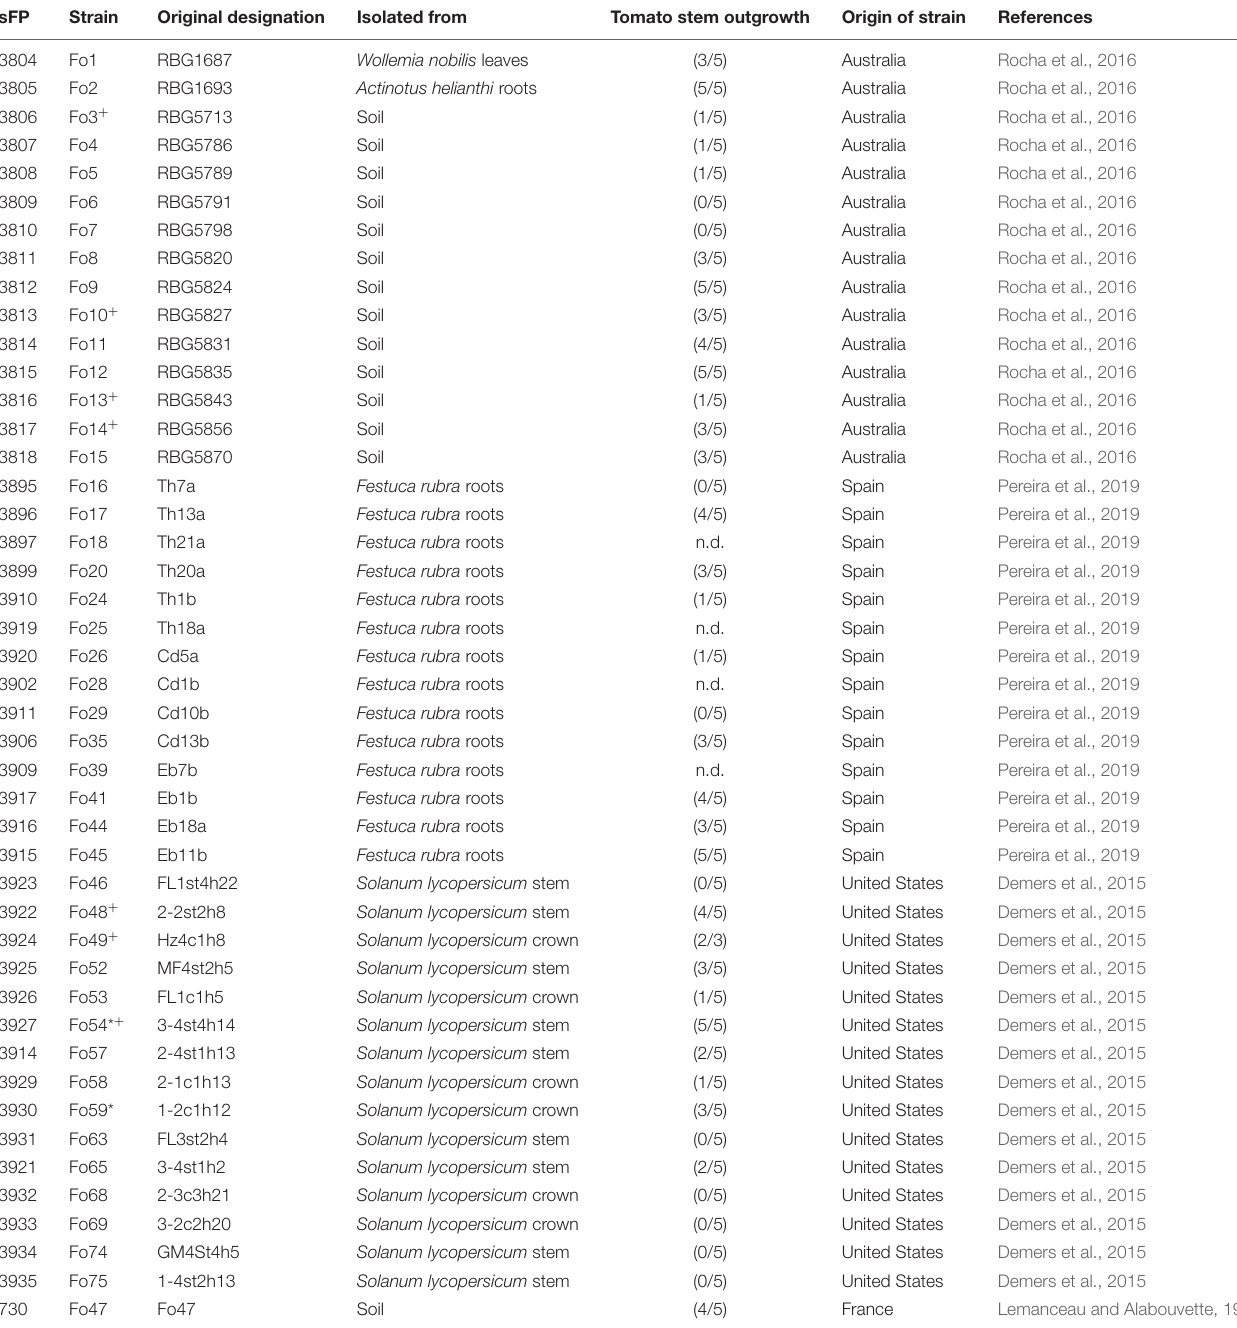
TABLE 1 | Endophytic and environmental strains of F. oxysporum investigated in this study. sFP